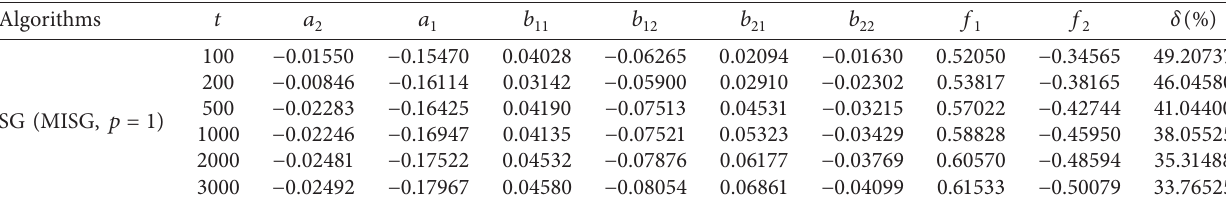
Table 5: The parameter estimates and errors with σ 2 � 1 . 00 2